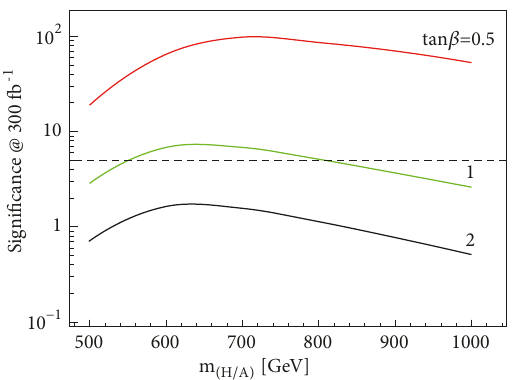
Figure 8: The 5𝜎 discovery region at 300 𝑓𝑏 −1